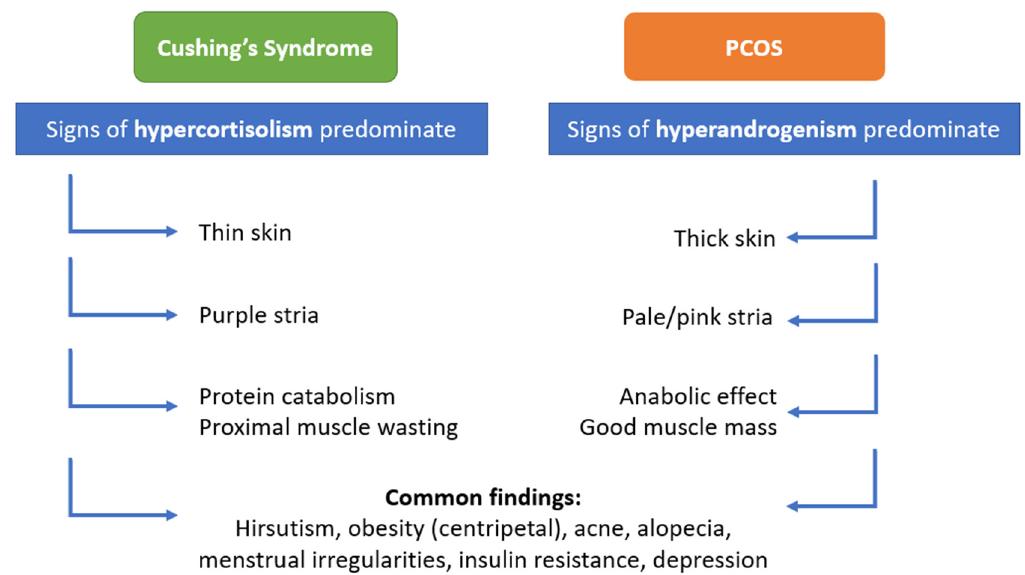
Figure 3. Clinical findings in CS and PCOS.